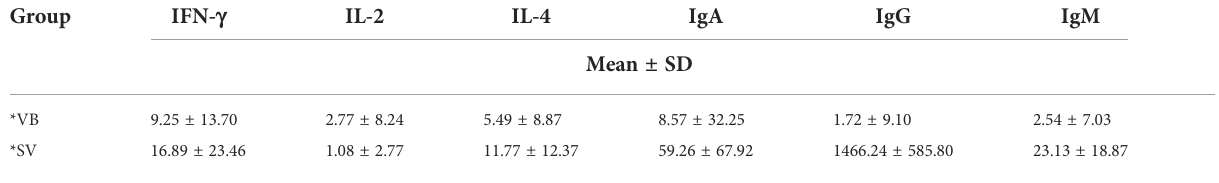
TABLE 1 Characteristics of the serum levels of cytokines and antibodies in the VB and SV groups.